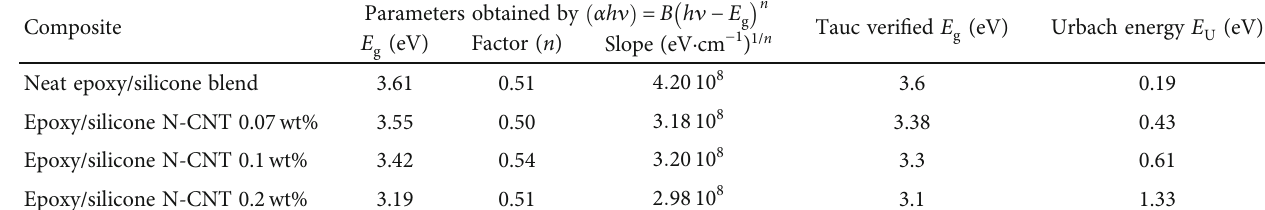
, and Urbach energy E g g